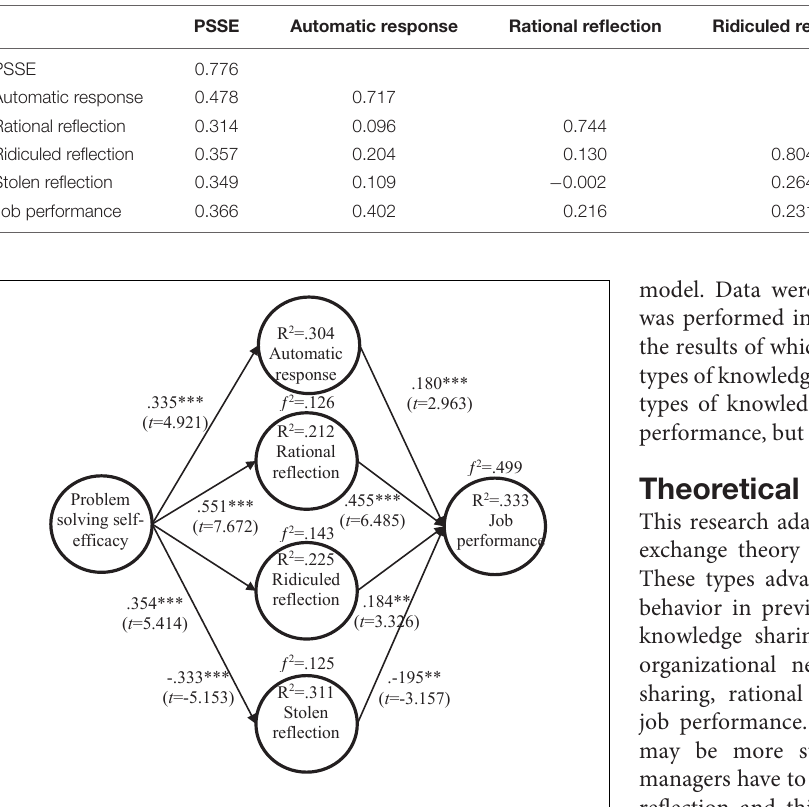
FIGURE 2 | Verification of the research model. ∗ p < 0.05, ∗∗ p < 0.01, ∗∗∗ p <